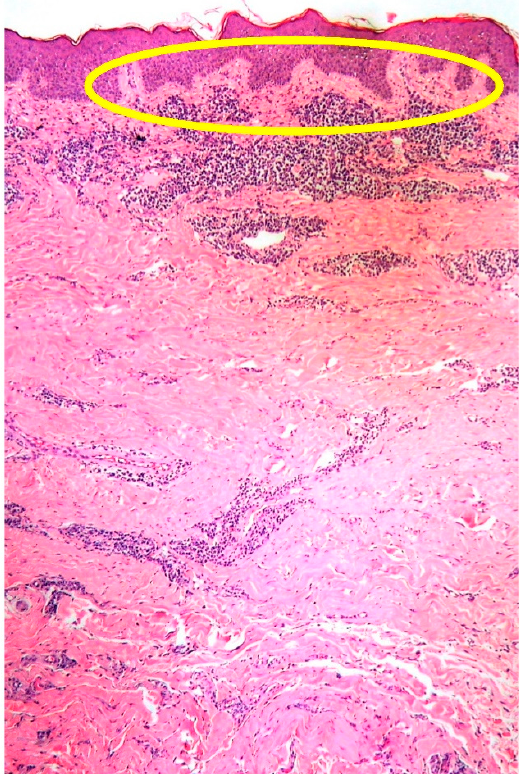
Figure 1. Low-power view of PCMZL, plasmacytic variant, showing a dermal, non-epidermotropic infiltrate (the lack of epidermotropism highlighted within the yellow circle) (HE, magnification 40×; original image from Prof. S.A.).